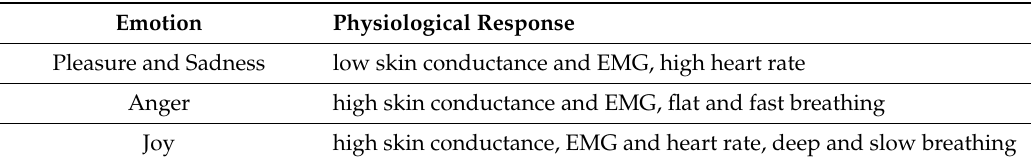
Table 2. Relation of emotions to physiological